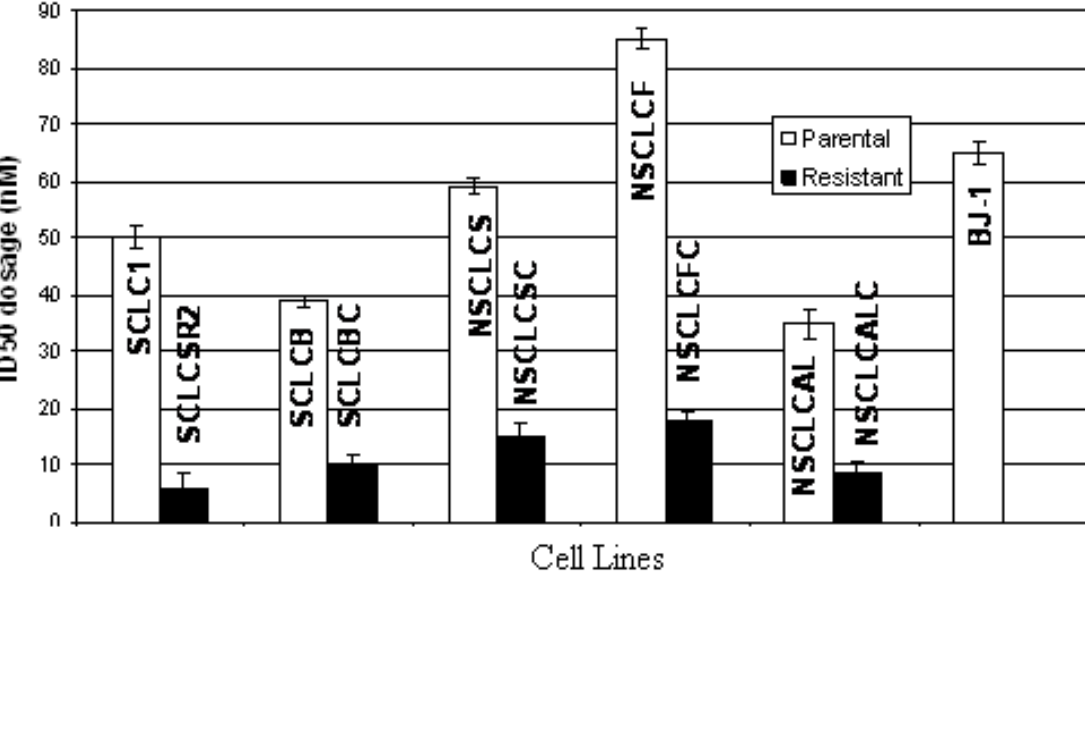
Figure 3. ID dosage of elesclomol in parental and cisplatin resistant lung cancer cell 50 lines. (SD of three experiments, average p values < 0.005; parental vs. resistant). BJ-1 was used as